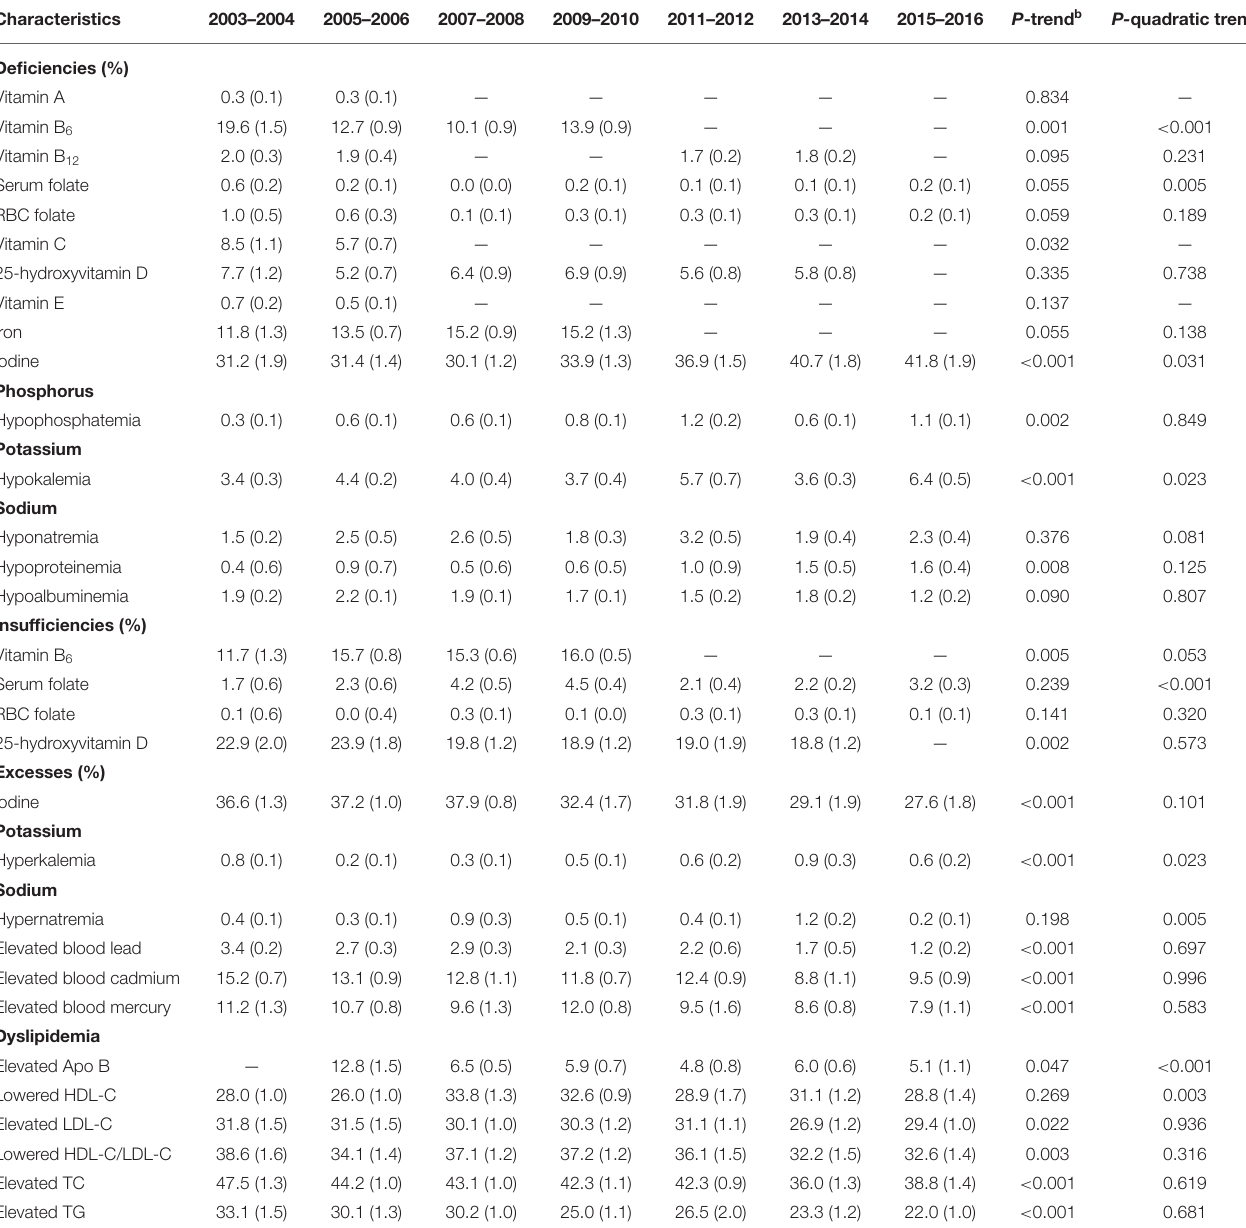
TABLE 3 | Trends of prevalence (SE) of deficiencies, insufficiencies, excesses, and dyslipidemia for nutritional biomarkers among US adults in the National Health and Nutrition Examination Survey (2003–2016) a .